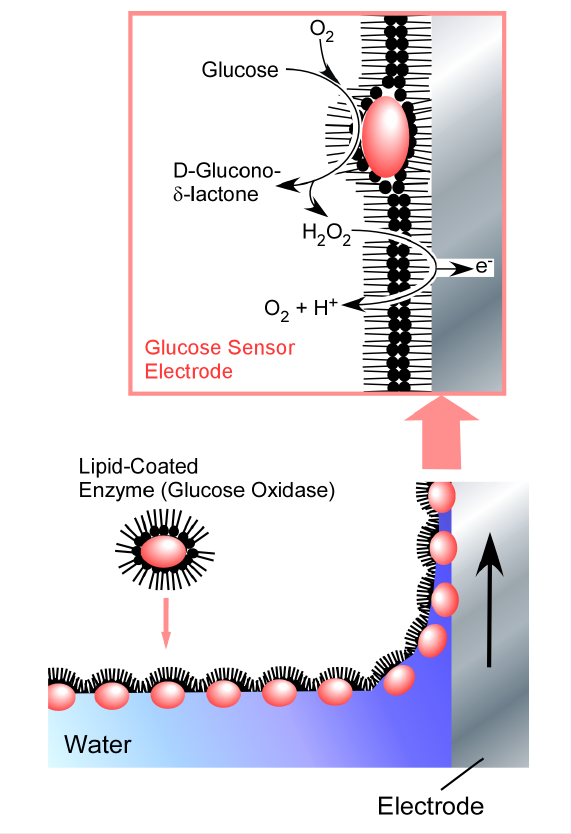
Figure 24: A monolayer of glucose oxidase complexed with a cationic lipid was transferred onto a surface of an electrode for glucose detec- tion sensors.